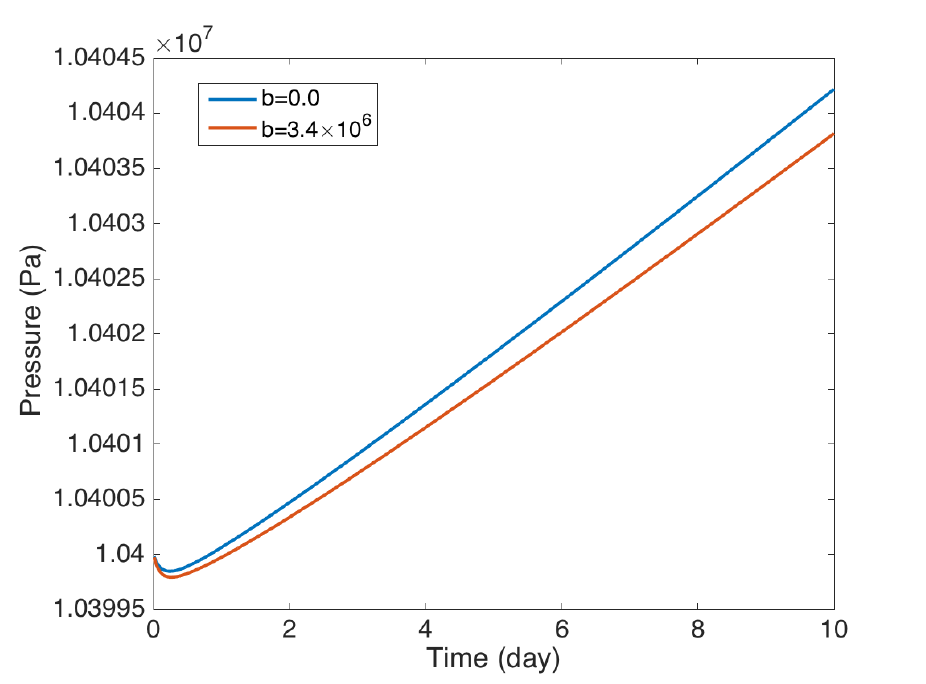
Figure 5. The average pressure profiles for various values of the coefficient